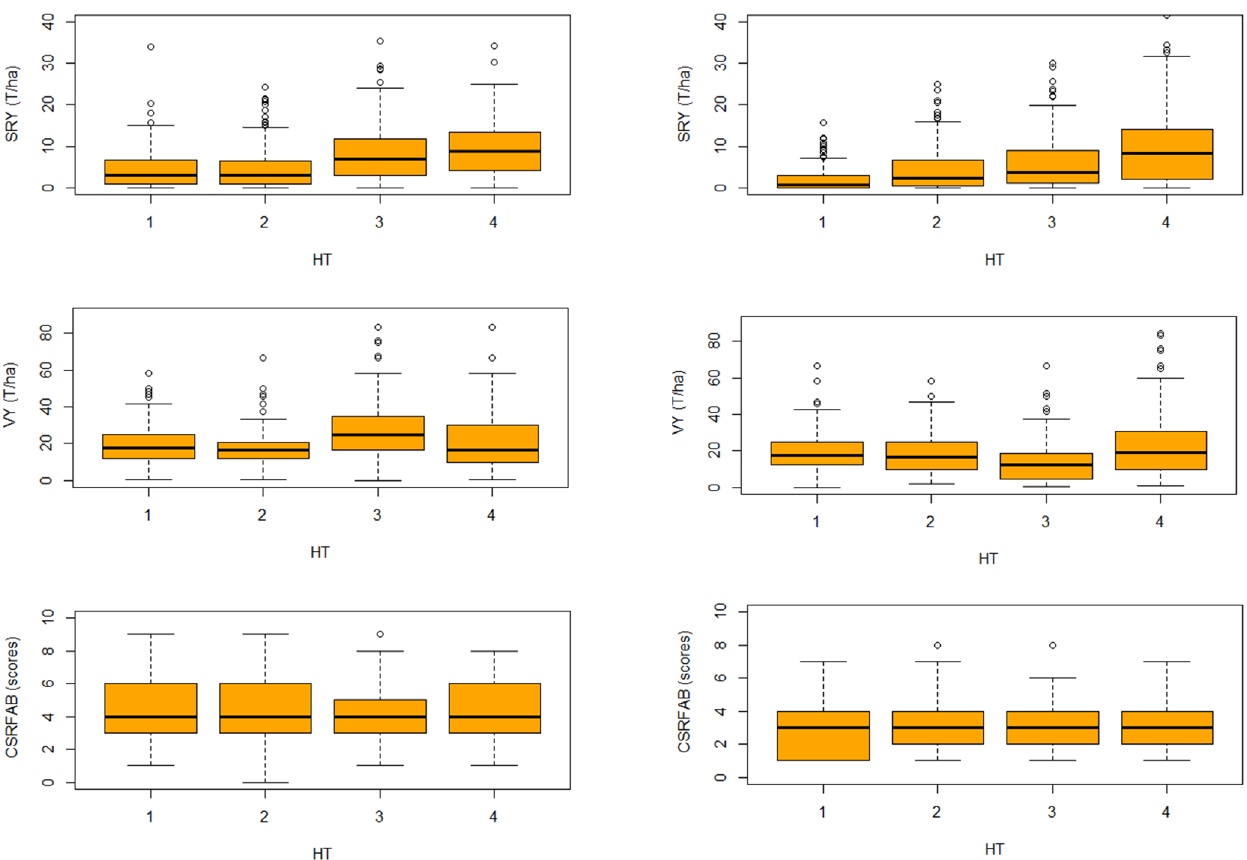
Figure 6. Two seasons (2016B & 2017A) boxplot comparison showing overall variability and dispersion of storage root yield (SRY), vine yield (VY) and continuous storage root formation and bulking (CSRFAB) over 4 harvesting times (HT) among 130 sweetpotato genotype at the National Crops Resources Research Institute (NaCRRI), Namulonge. Note: SRY = storage root yield; VY = vine yield; HT = harvesting time; 1 = 90DAP; 2 = 120 DAP; 3 = 150 DAP; 4 = 180